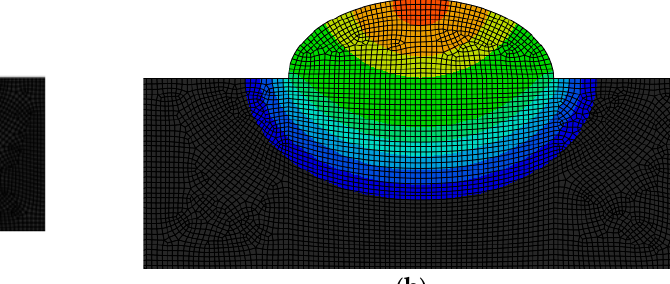
Figure 10. Temperature distribution by timeline before and after welding. Times were ( a ) − 0.5 s (before the heat source arrives); ( b ) − 0.1 s (before the heat source arrives); ( c ) 0 s (when the heat source is directly above); ( d ) 0.5 s elapsed; ( e ) 1.0 s elapsed; ( f ) 2.0 s elapsed; ( g ) 4.0 s elapsed.